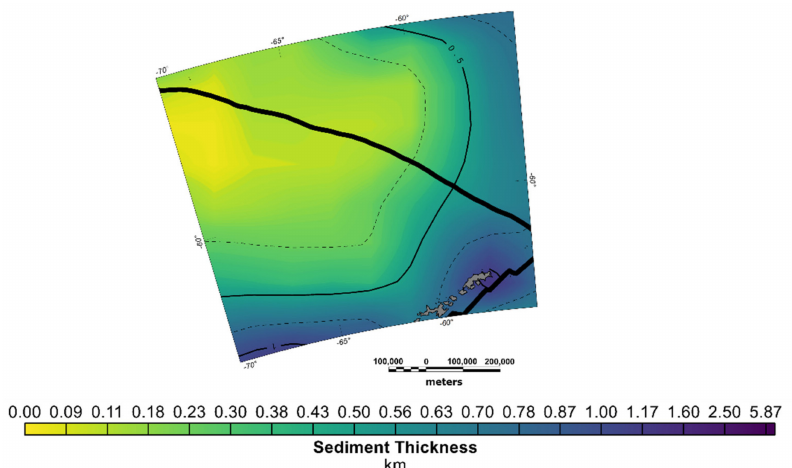
Figure 4. Sediment thickness map of the study area. Contour lines every 250 m. Plate boundaries are denoted by black solid thick